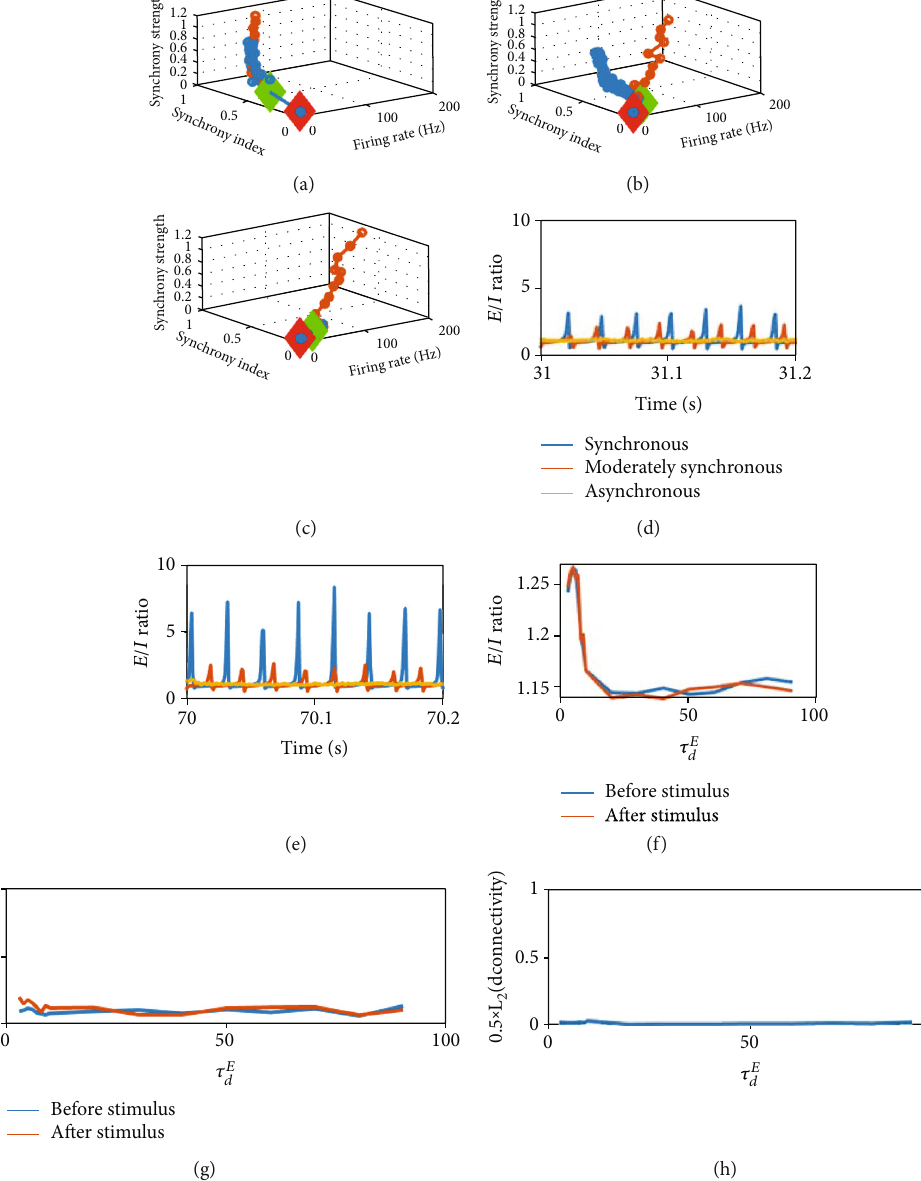
Figure 9: Other dynamic properties. (a – c) Blue curves are the evolution dynamics in circuits with plasticity starts from strength 0.1. Red diamond represents the start of simulation, and green diamond represent the start of extra stimulus. Orange curves are the results of static circuits with di ff erent synaptic strengths. (a) Synchronous dynamics with τ E = 6ms . (b) Moderately synchronous dynamics with τ E = 10ms d d = 90ms . The other parameters: τ I = 8ms, As = 3 : 5 . Transient excitatory and inhibitory current ratio . (c) Asynchronous dynamics with τ E d d in early stage of stimulus (d) ( < 5 s after applying extra stimulus input at t = 30s ) and late stage of stimulus (e) (after synaptic weight stabilized). (f) Average E/I ratio before extra stimulus and after the removal of stimulus. (g) Firing rate before and after extra stimulus. (h) L2 norm of the di ff erence of the connectivity matrices (reshaped to 1d and normalized) at the removal of the extra stimulus and 10s later under normal background